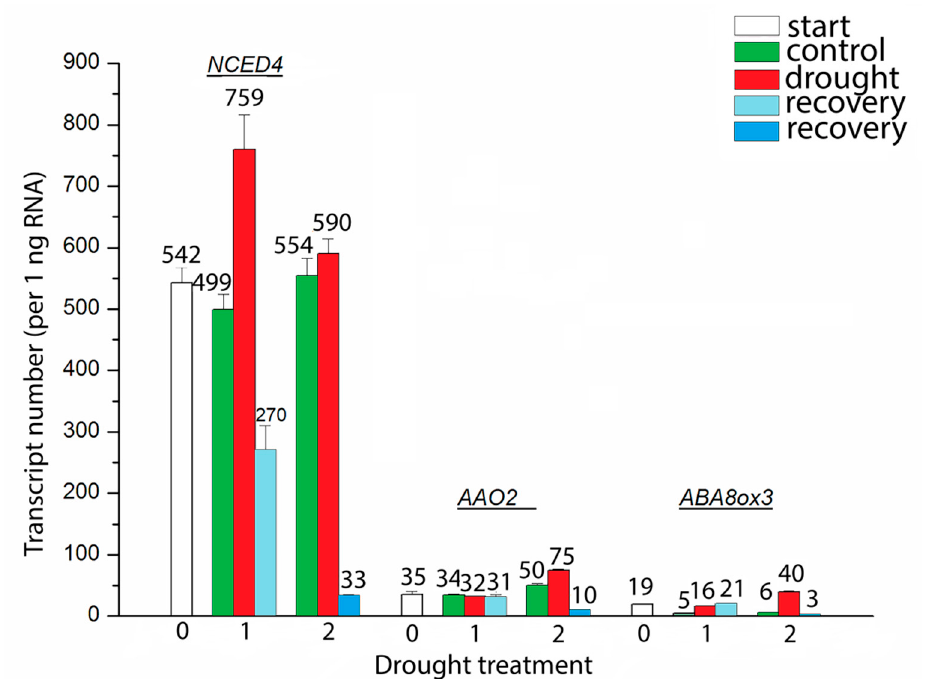
Figure 5. The effect of drought on 9-cis-epoxycarotenoid dioxygenase 4 ( NCED4 ), abscisic aldehyde oxidase 2 ( AAO2) and ABA 8 ′ -hydroxylase 3 ( ABA8ox3 ) gene expression in I. walleriana grown ex vitro. The “start point”, 15% and 5% of soil moisture content—0, 1 and 2, respectively; results represent mean ± SE ( n = 8).